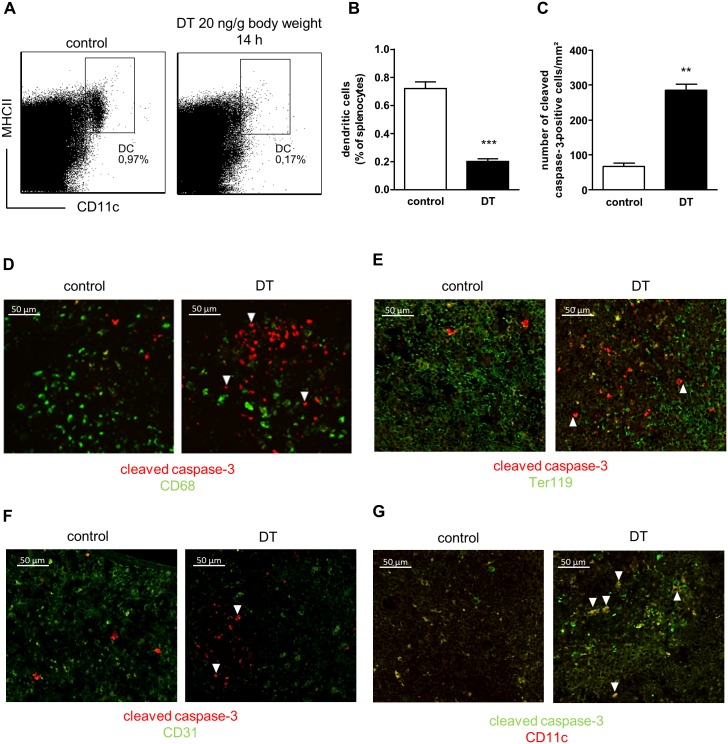
In vivo validation of the Zbtb46-DTR model to deplete cDC.(A,B) Representative dot plots (A) and flow cytometric analysis (B) of splenocytes of Zbtb46-DTR mice sacrificed 14h after a single injection with vehicle (control, n = 6) or 20ng DT/g.bw (n = 5); Differences between groups were analyzed by means of a Student t test, ***p<0.001; (C) Quantification of cleaved caspase-3 positivity in spleens (average of 3 measurements per mouse, n = 2 mice per group); Differences between groups were analyzed by means of a Student t test, **p<0.01; (D-F) Cleaved caspase-3 (red, arrow heads) and (D) CD68, (E) CD31, and (F) Ter119 staining of spleens from Zbtb46-DTR mice treated with vehicle (control) or DT (20ng/g.bw, 14h); (G) Double staining of spleens from control or DT-treated Zbtb46-DTR mice with cleaved caspase-3 (green) and CD11c (red). Arrow heads indicate apoptotic CD11c+ cells; Scale bar = 50μm.